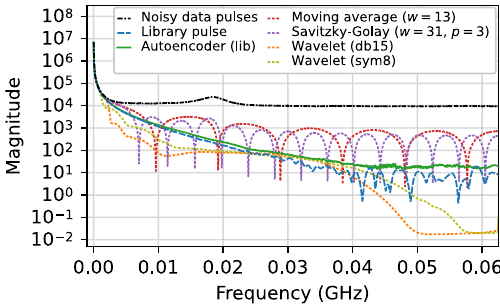
Fig. 12 Comparison of the frequency spectra for simulated library pulses,noisypulses,pulsesdenoisedwiththeautoencodertrainedusing the regular procedure and library pulses, and pulses denoised with four different traditional denoising methods